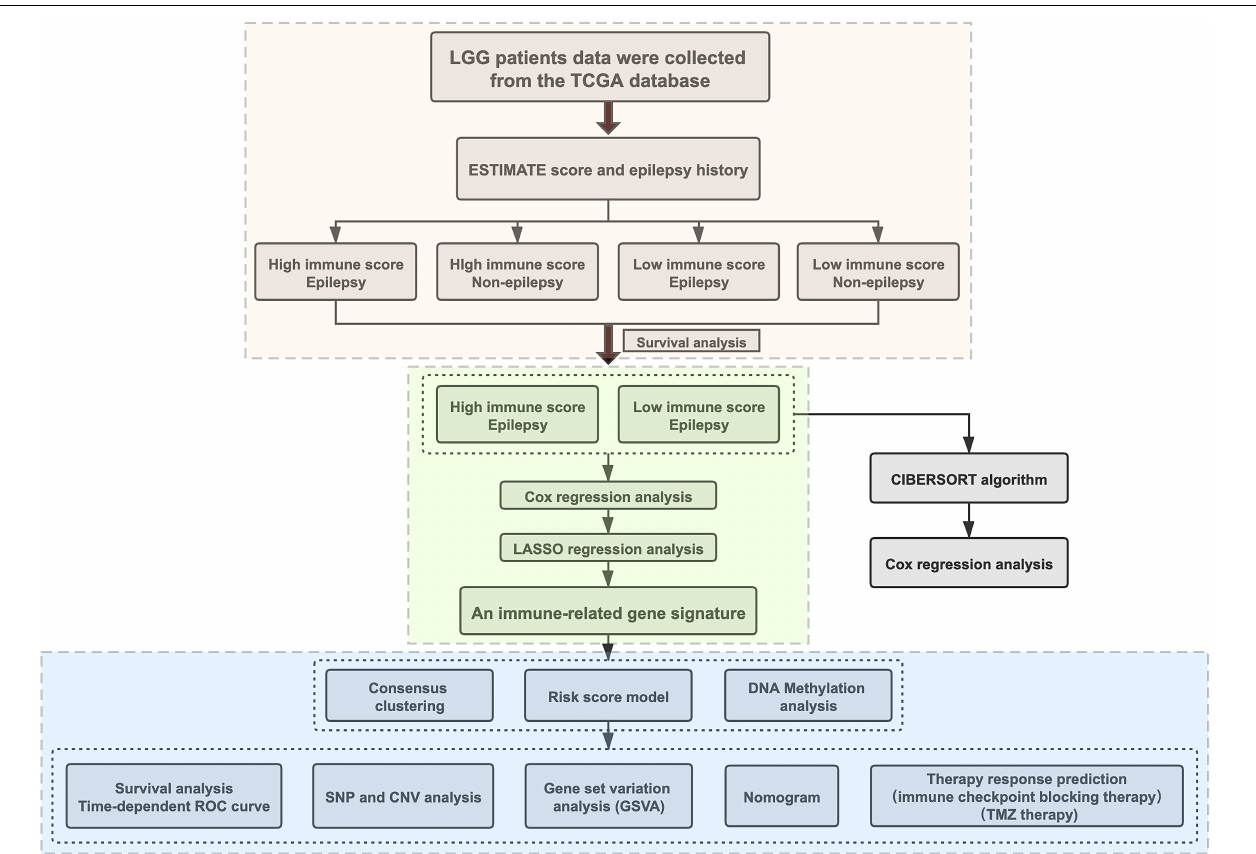
FIGURE 1 | The flowchart designed for the